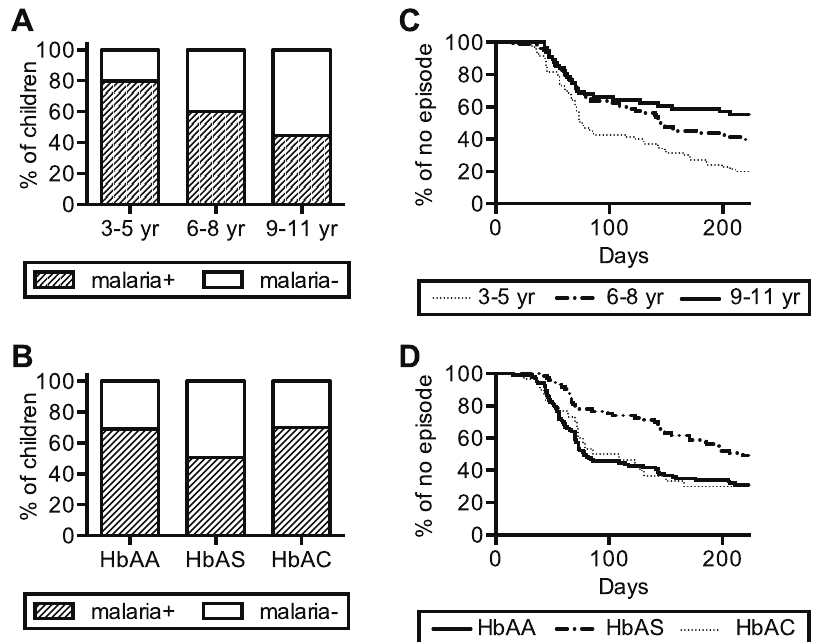
Figure 1. Increasing age and HbAS significantly protect Malian children against malaria. (A & B) The proportion of children who experienced at least one episode of malaria (malaria + ) in the 2009 transmission season is shown. The children are categorized by age (A) or Hb type (B). (C & D) Survival analyses of the time to first malaria episode. Kaplan-Meier plots are shown for children grouped by age (C) or Hb type (D). Increasing age and HbAS were significantly associated with reduced malaria risk as measured by whether or not malaria was experienced (Figure 1A, p , 0.0001; Figure 1B, p=0.0203; chi-squared tests), or time to first malaria episode (Figure 1C, p=0.0002; Figure 1D, p=0.0013; by log-rank tests). doi:10.1371/journal.pone.0060182.g001 PLOS ONE |